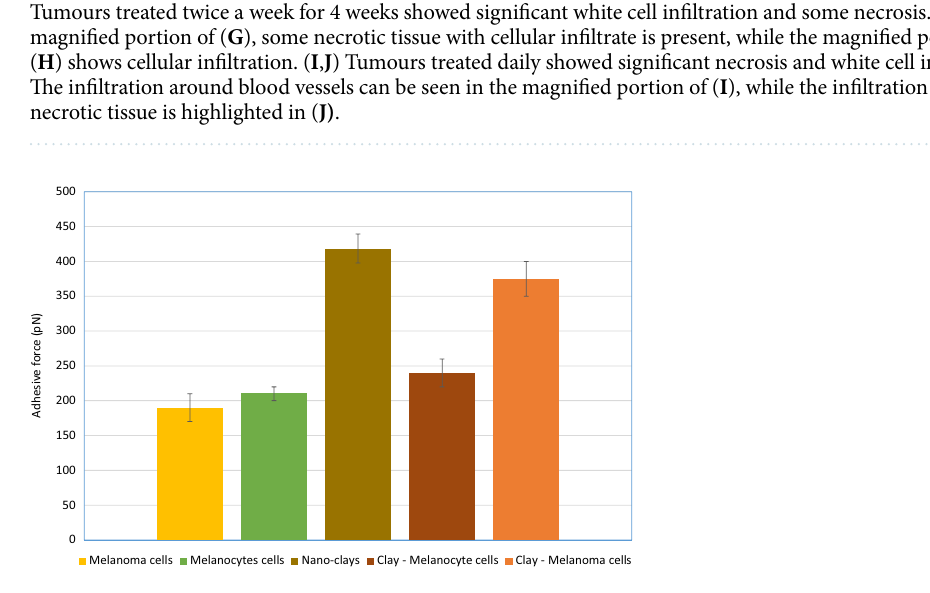
Figure 5. Summary of adhesion force measurements among melanoma and melanocyte cells using AFM, before and after treatment with clay nanoparticles. Error bars represent the variations in adhesive force in three